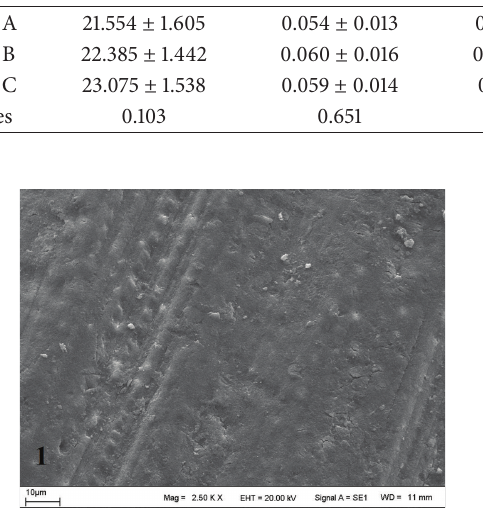
Figure 1: SEM micrograph of dentin surface in control group (original magnification × 2.50 k).